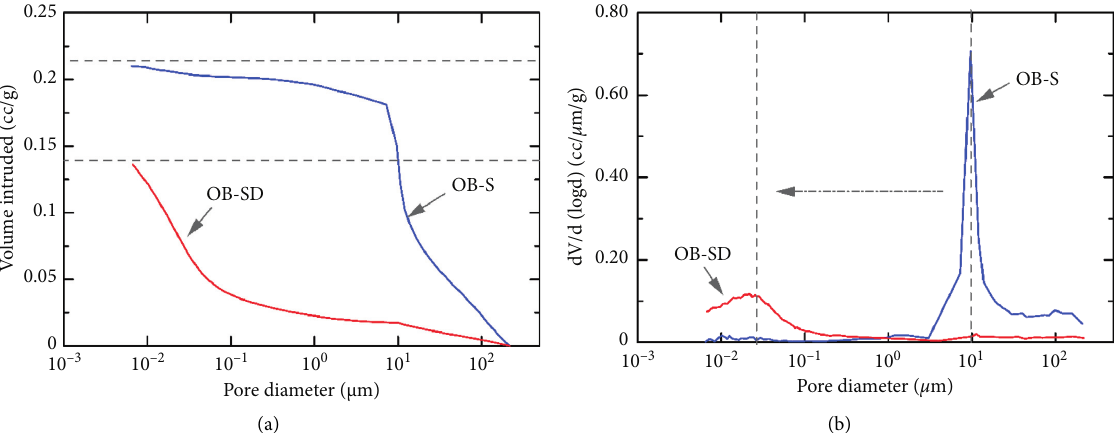
Figure 10: PSD of original bentonite samples at paste state (OB-S) and subsequent drying (OB-SD) by MIP. (a) Cumulative pore volume and (b) PSD density.